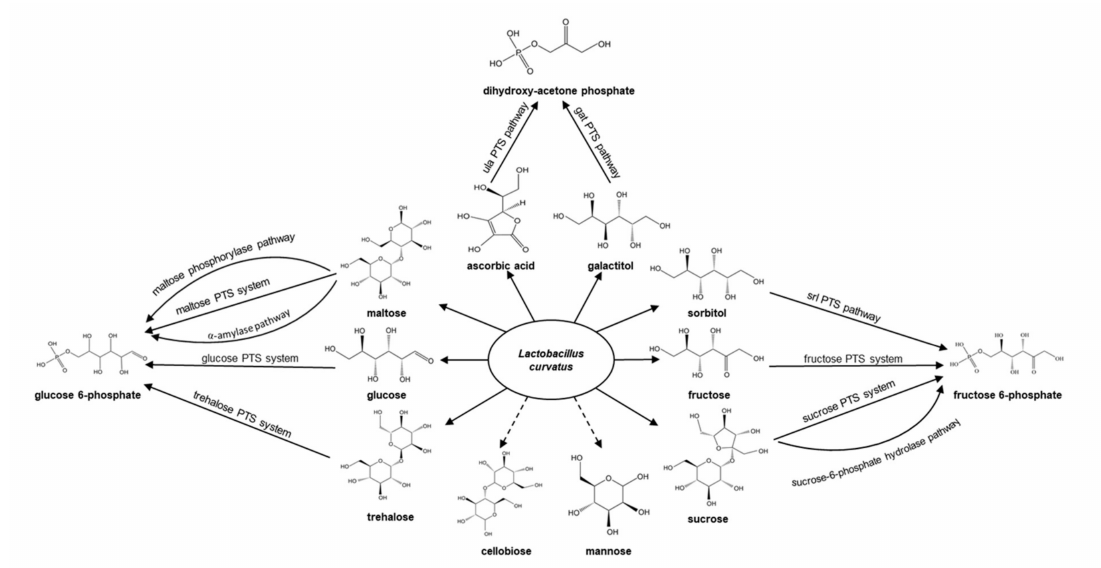
Figure 2. Carbohydrate utilization map of Latilactobacillus curvatus. Carbohydrates are divided into sugars and polyols. Solid lines represent carbohydrates that have evidence supporting their use by L. curvatus, and dashed lines represent carbohydrates that L. curvatus may use, but for which there is no supporting evidence. PTS: